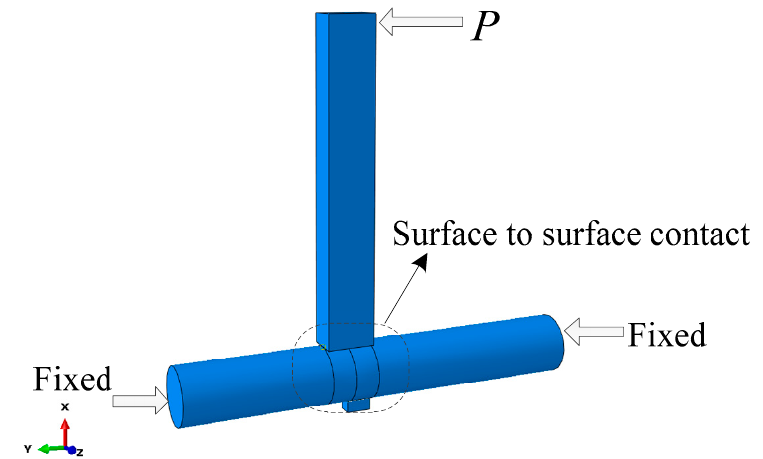
Figure 28. Boundary conditions.